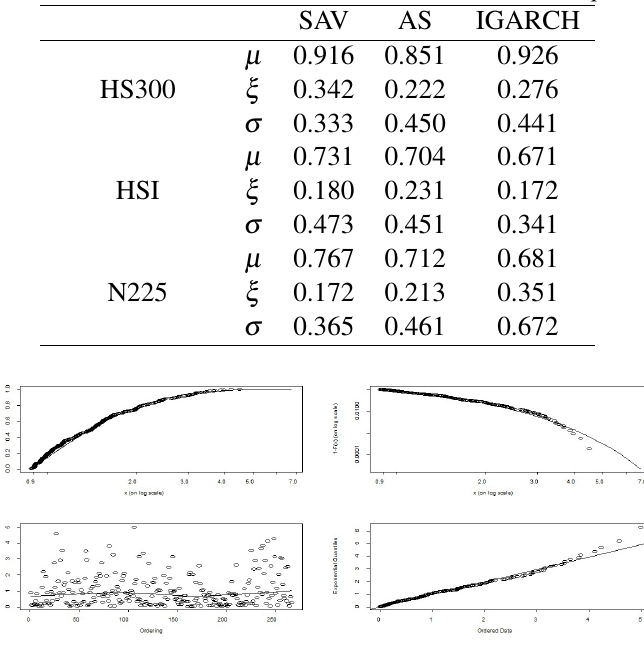
Fig. 3 POT model diagnosis diagram of HS300 extreme residual sequence